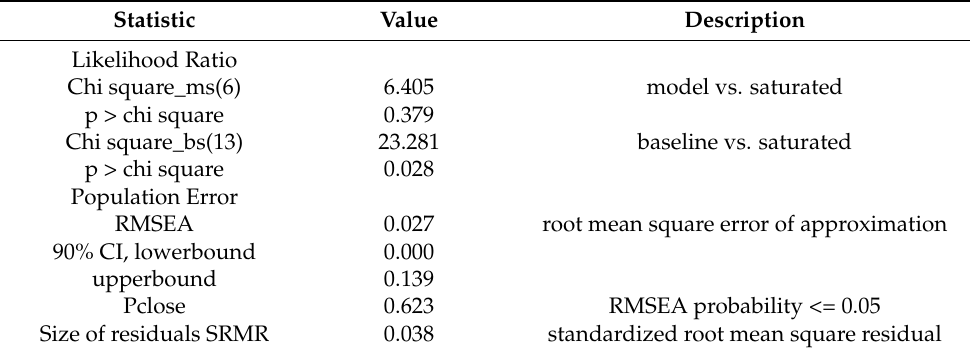
Table 5. Goodness of fit of the structural model. Source: own elaboration based on Stata 14.